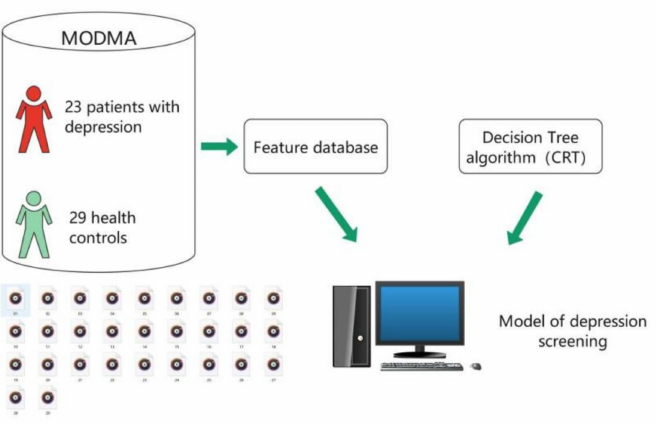
Figure 1. Brief introduction of the generation process of depression screening